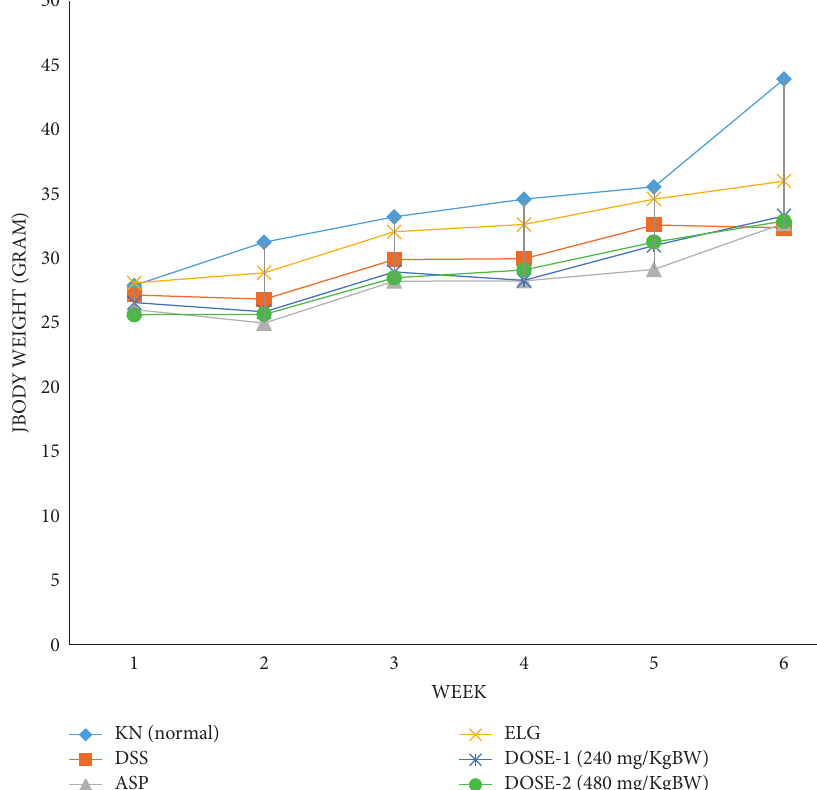
Figure 2: Changes in body weight in various treatment groups were measured per week. KN was normal, DSS group was negative control, Asp was aspirin treated which was a positive control, ELG was the group treated with ellagic acid, dose 1 was the pomegranate peel extract of 240mg/kg/day, and dose 2 was the pomegranate peel extract of 480mg/kg/day.